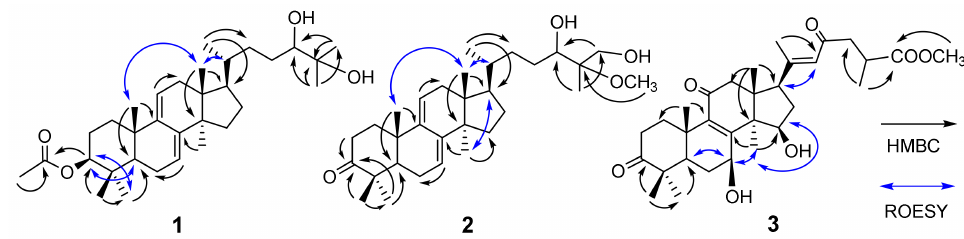
Figure 2. Key HMBC (H → C) and ROESY ( ↔ ) correlations of 1 – 3 . Compound 2 had the molecular formula C 31 H 50 O 4 , as determined by the HRES- IMS ion peak at 509.3597 (calcd. 509.3607 for C 31 H 50 NaO 4+ ). The 13 C NMR and